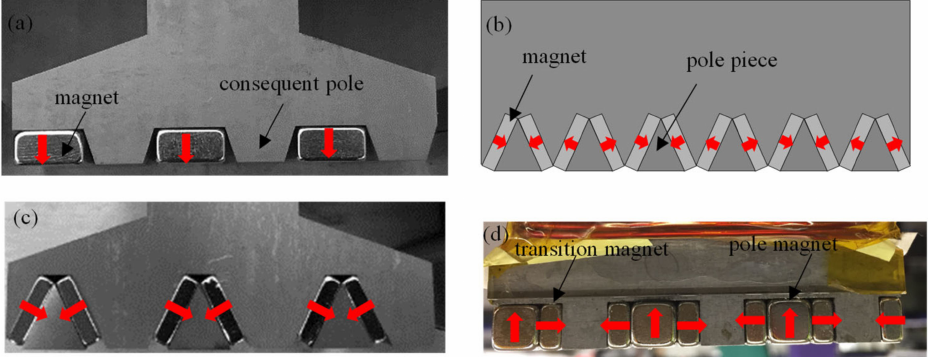
Figure 5. Laboratory prototypes of the flat VHMs showing the ( a ) consequent poles, ( b ) V-shape ( c ) V- shape consequent pole and ( d ) Halbach array consequent pole.